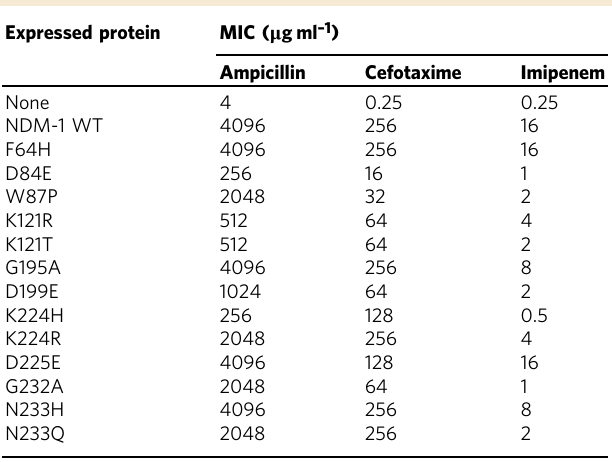
Table. 1 Antibiotic resistance levels of wild-type and mutants Expressed protein MIC ( μ g ml – 1